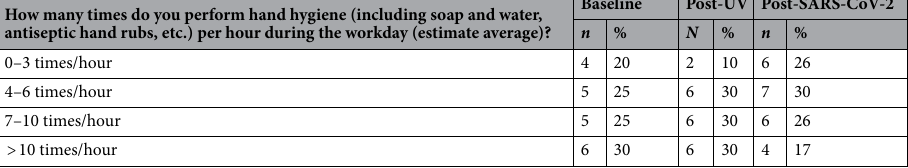
How many times do you perform hand hygiene (including soap and water, antiseptic hand rubs, etc.) per hour during the workday (estimate